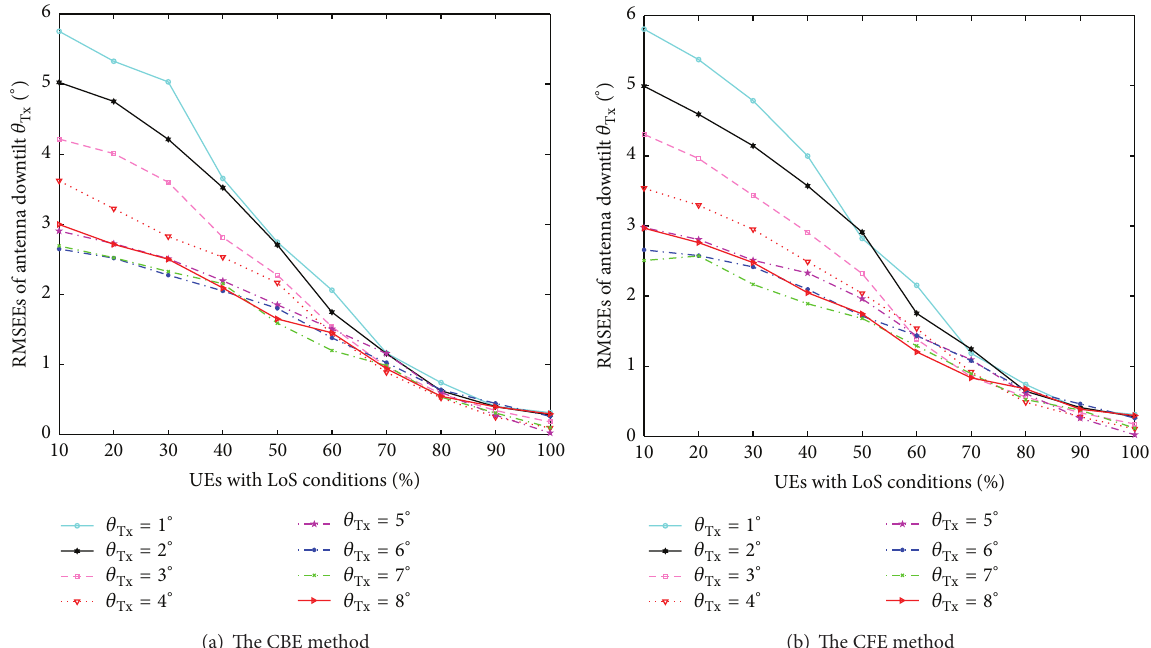
Figure 10: The RMSEEs of the antenna downtilt versus the percentage of the UEs in the LoS positions among all available UEs.